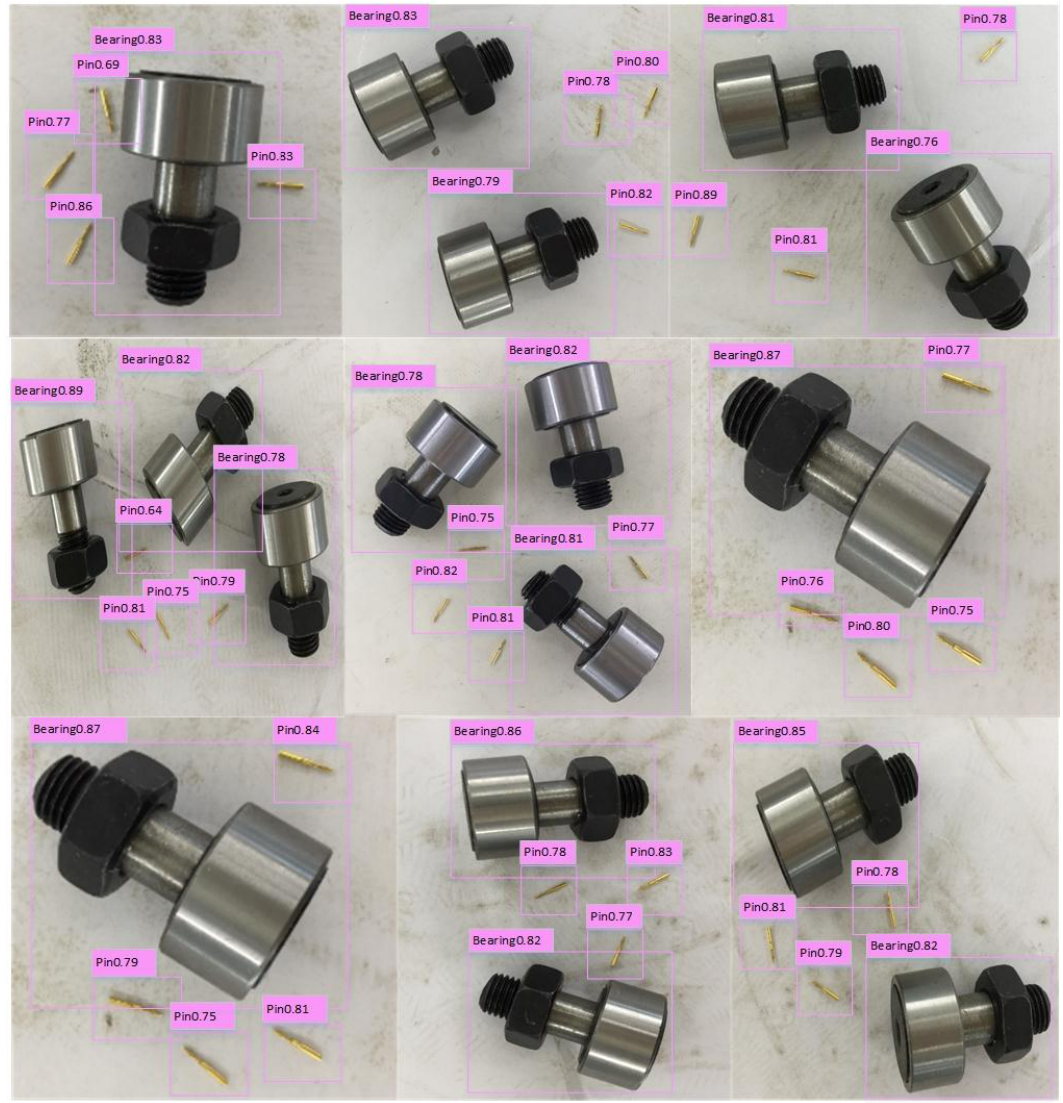
Figure 10. Multi-category test result.